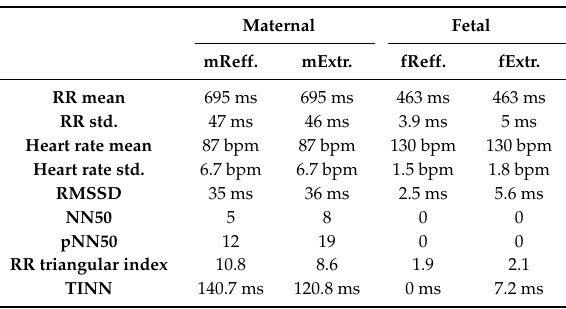
Table 6. Time domain